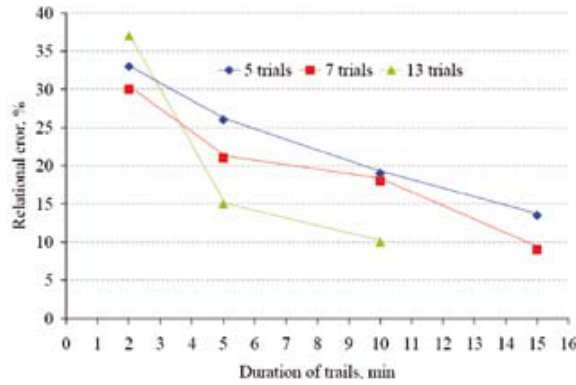
fig. 2. Upper confidence limits of the error of arithmetic mean